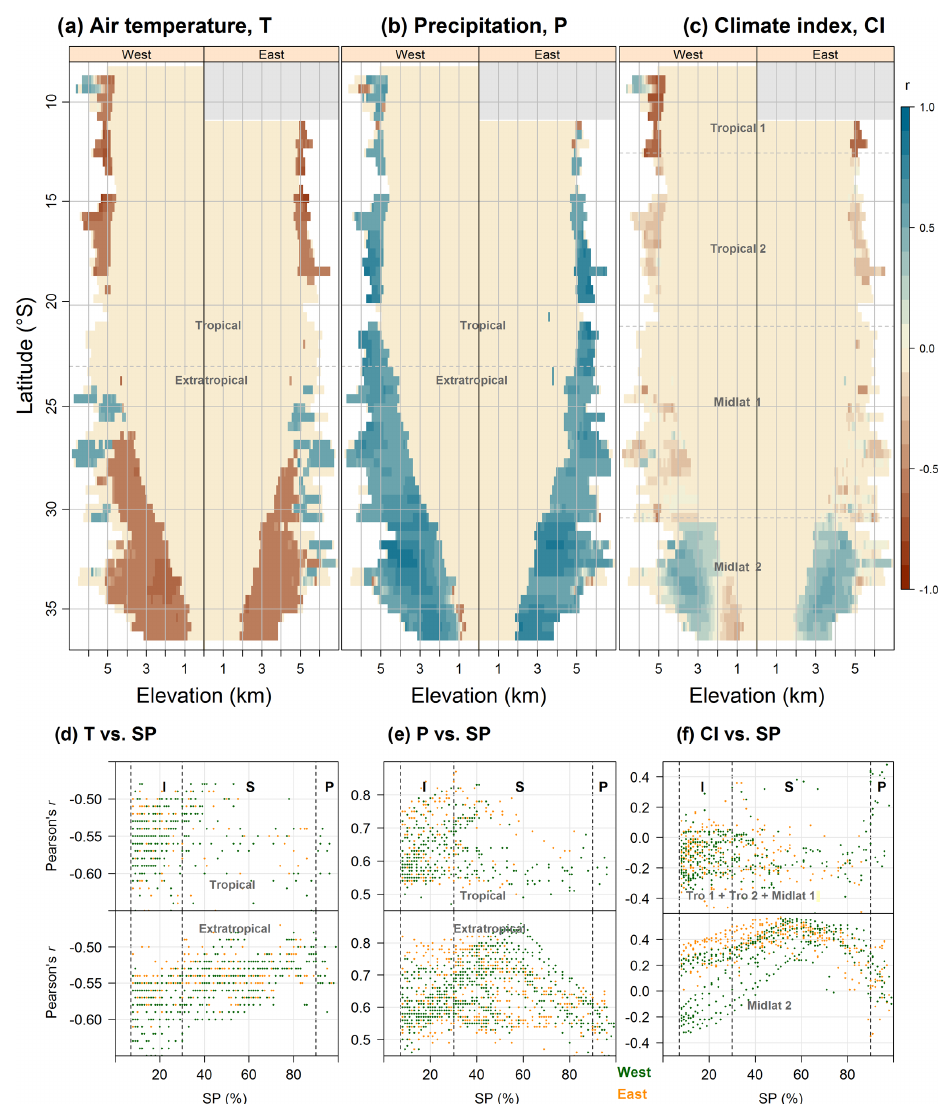
Figure 9. Latitude–elevation band analysis by side of the continental divide (west–east) for Pearson’s correlation coefficient ( r ) between annual snow persistence and (a) air temperature, (b) precipitation, and (c) climate indices. Gray areas represent latitudes masked due to the high frequency of cloud cover in snow-covered area analysis ( > 30% period). Plots (d) , (e) , and (f) show values for each latitude–elevation band change by SP in west (green) and east (orange) sides. Vertical dashed gray lines represent thresholds for intermittent (I), seasonal (S), and persistent (P) snow